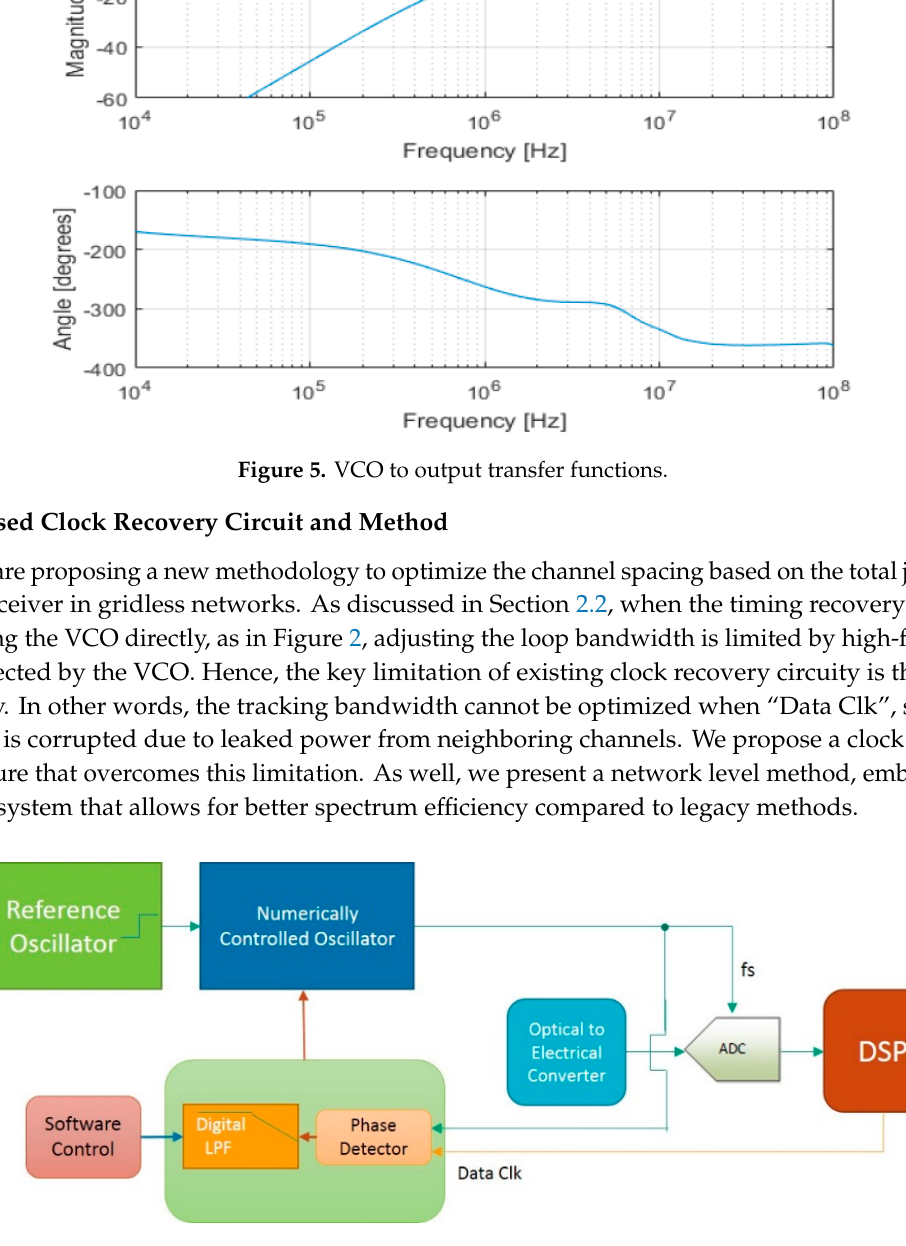
Figure 6. Clock recovery circuit used in proposed method.